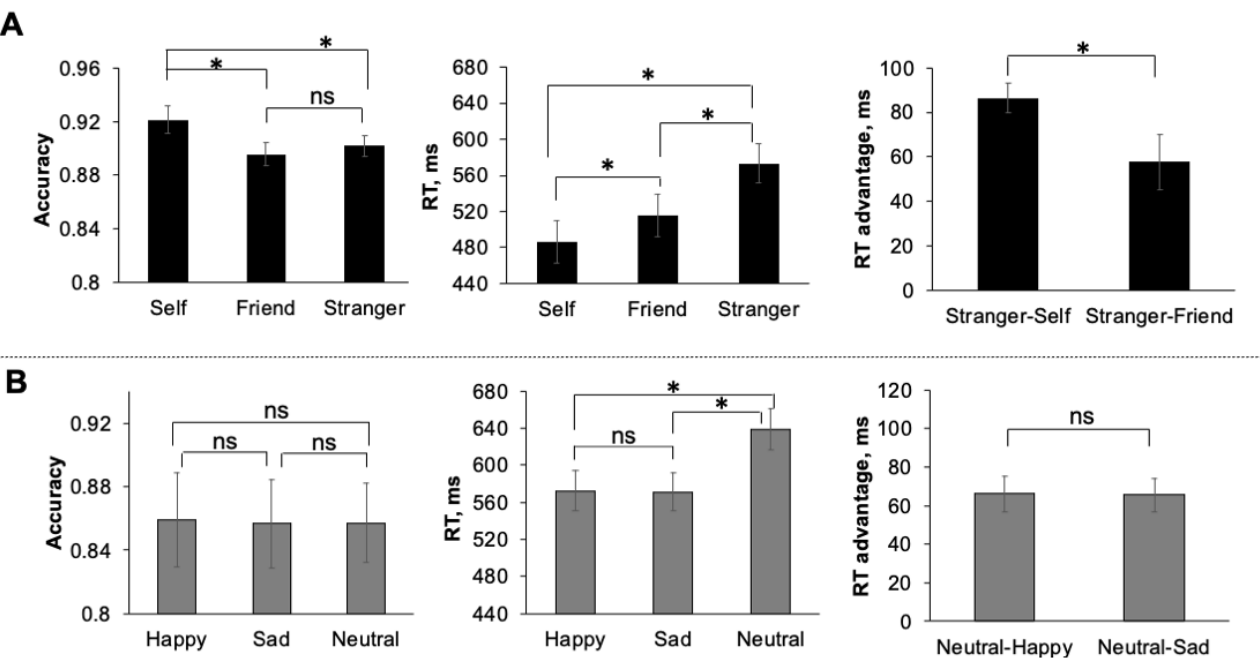
Figure 2. Accuracy, reaction times and RT advantages in personal (raw A ) and emotional (raw B ) tasks. Error bars represent ± SEM. * p < 0.05.